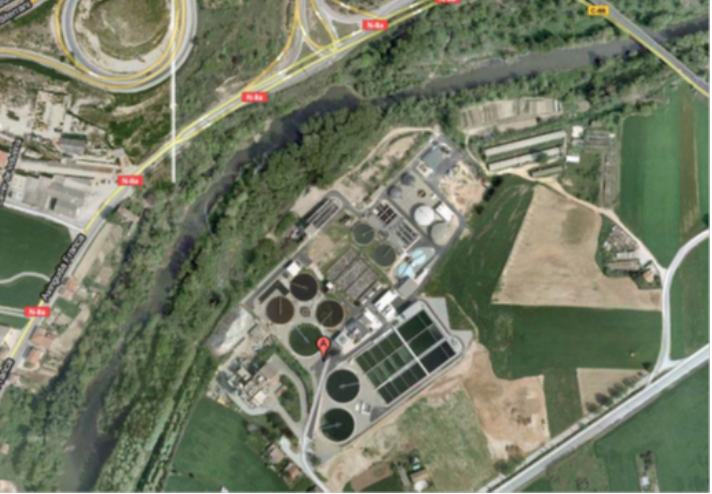
Figure 1. Girona Wastewater Treatment